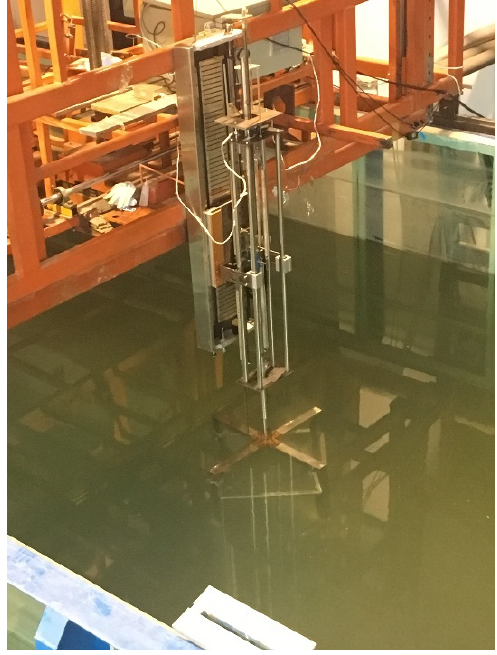
Figure 2. A picture of the THPEH model in the wave flume.